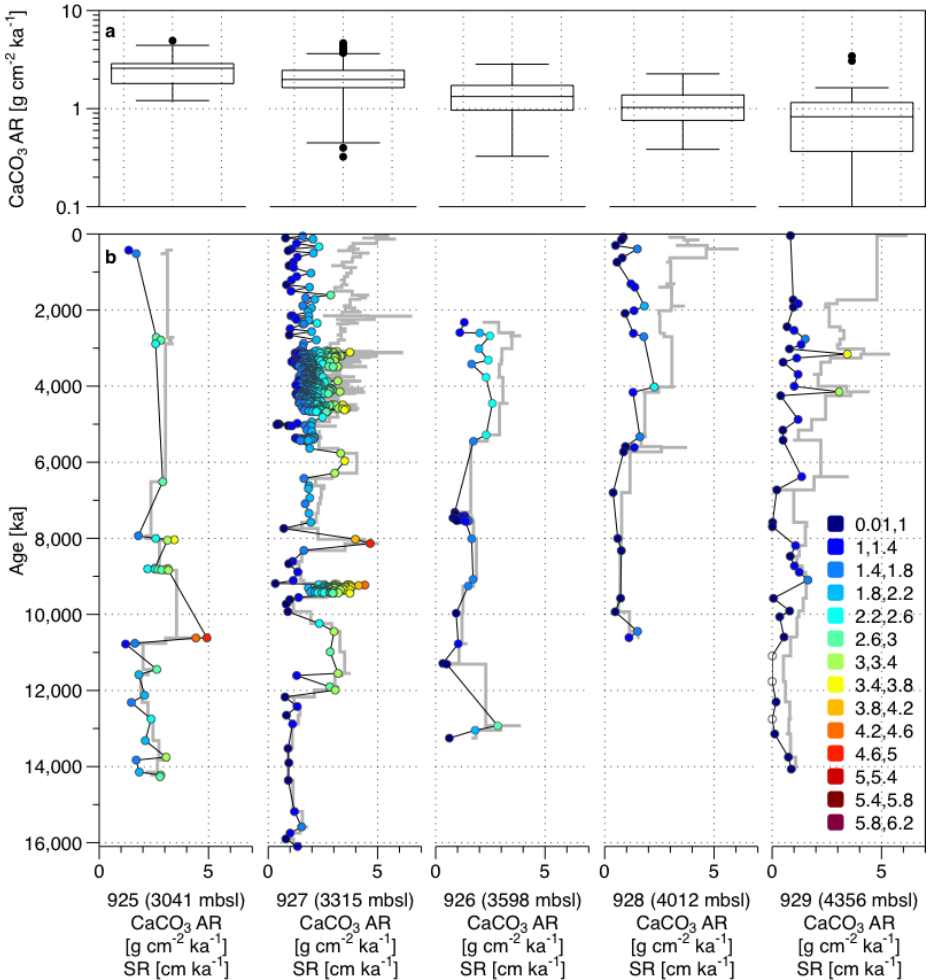
Figure 3. (a) Box plots of the CaCO 3 AR for the five cores and (b) CaCO 3 AR and SR (grey line) through the time for the Sites 925, 926, 927, 928, and 929 (black line and dots) for the five cores of the Leg 154. The CaCO 3 AR are calculated from existing carbonate content data for all Leg 154 sites (Curry et al., 1995; Frenz et al., 2006; King et al., 1997). The colour shade corresponds to the values of CaCO 3